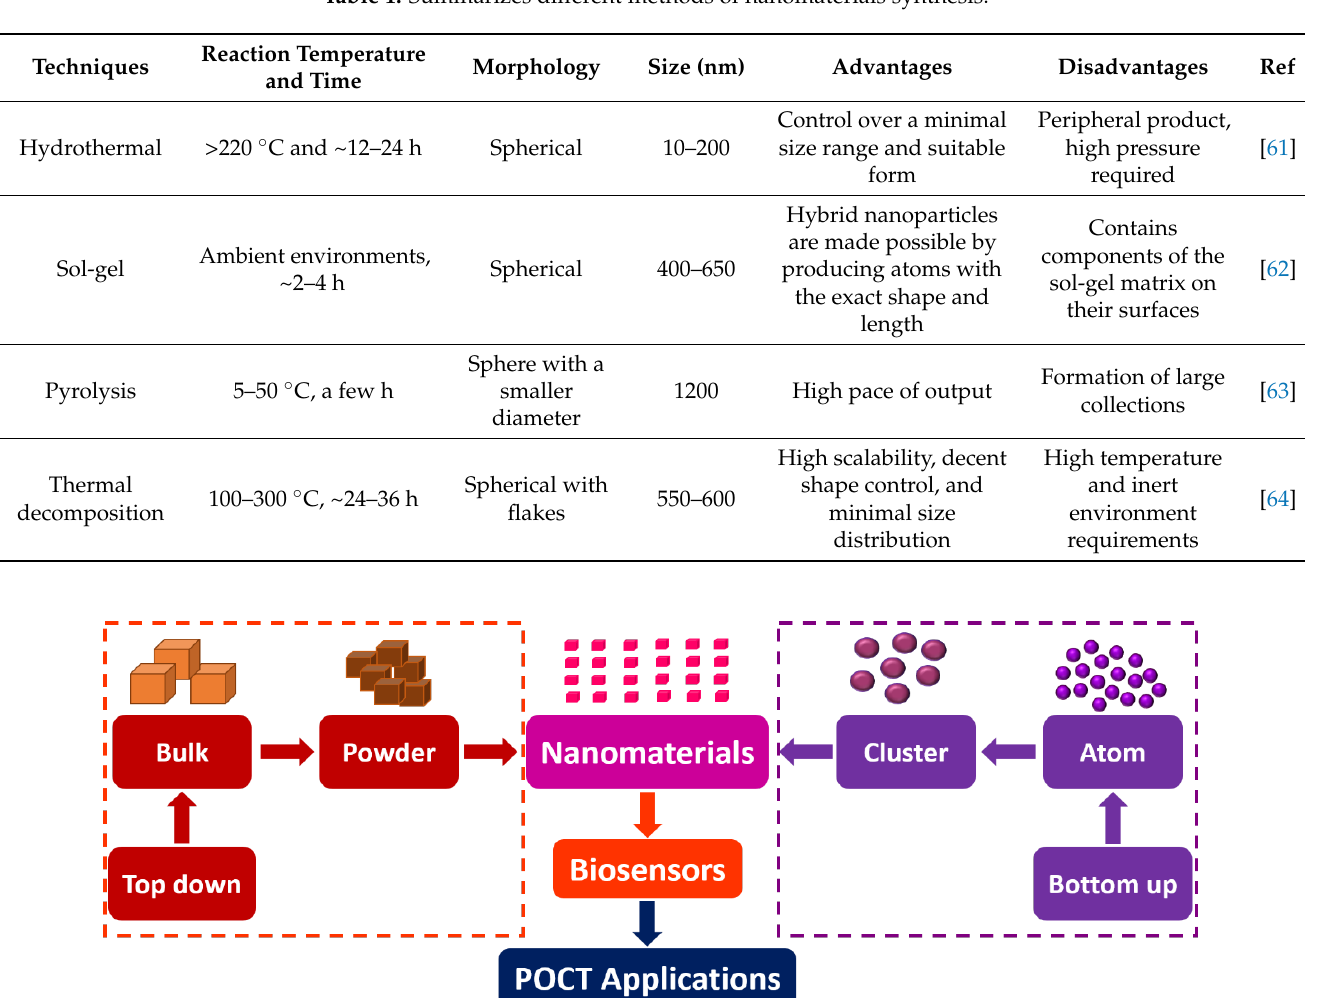
Figure 4. Schematic of the top-down and bottom-up approaches of nanomaterials